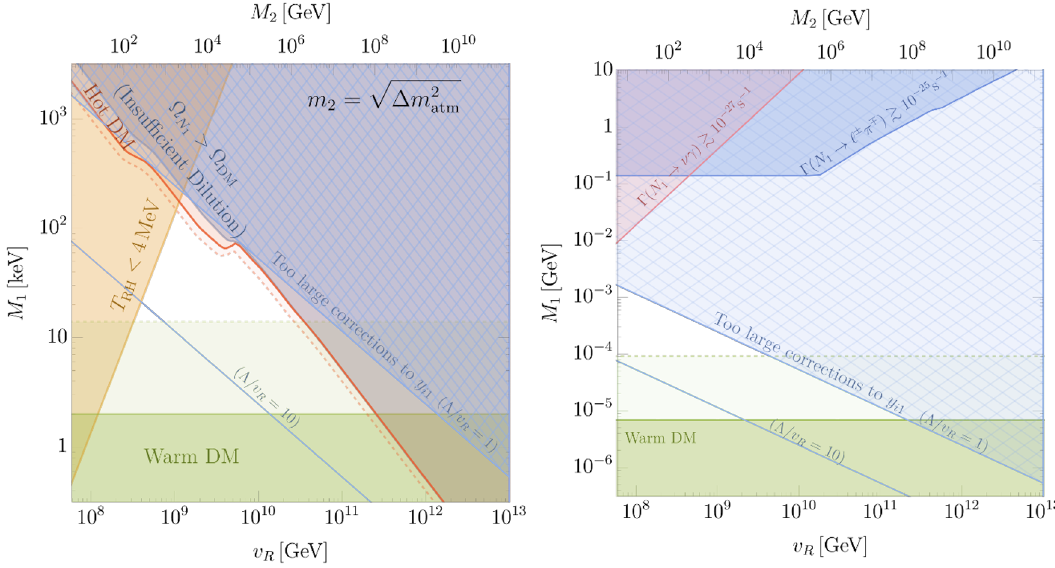
Figure 7 . The parameter space where the mass and stability of N 1 DM can be realized without fine tuning in the effective theory ‘‘H L H L + ¯ ‘ ¯ ‘H R H R + ‘ ¯ ‘H L H R . The charged fermion masses are UV completed below v R to avoid the radiative correction of figure 5. In the hatched blue region, the value of y 33 required to set x ≡ ( M 3 /M 2 ) 2 ’ 1 for leptogenesis, approximately m 33 v R /v 2 , is sufficiently large that the tree and loop contributions to y i 1 must be unnaturally tuned to keep N 1 stable when Λ /v R = 1 . Λ is the UV cutoff. The lower blue contour shows the same region if Λ /v R = 10 . The unhatched shaded regions are constraints solely on N 1 DM in the freeze-out (left) and freeze-in (right) cosmologies, as in figures 2 and